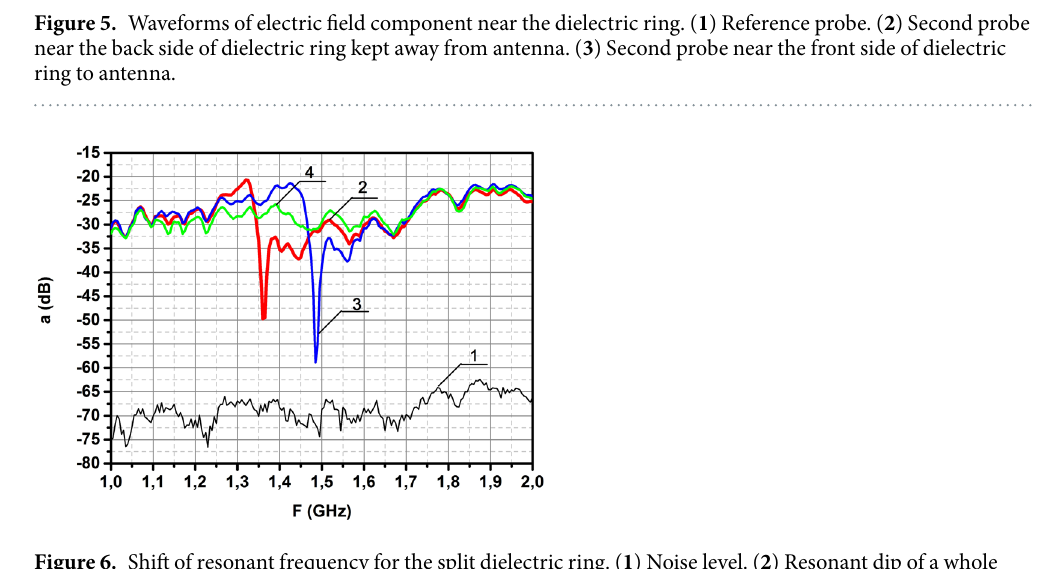
Figure 6. Shift of resonant frequency for the split dielectric ring. ( 1 ) Noise level. ( 2 ) Resonant dip of a whole ring. ( 3 ) Resonant dip for the split dielectric ring with the width of slit d = 0.01 cm. ( 4 ) Spectrum of horse shoe- like scatterer with the doubled thickness formed from two halves of